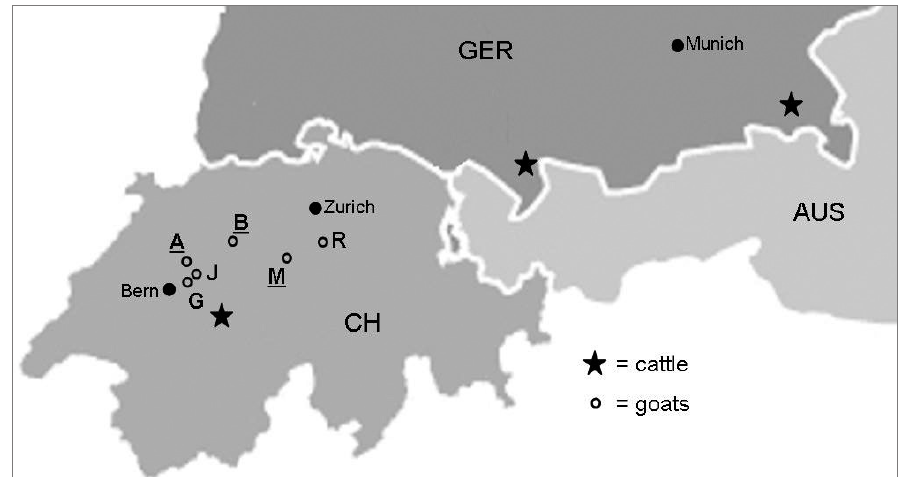
A, B, G, J, M, R, goat flocks investigated; underlined letter = flocks where A. phagocyto- philum was